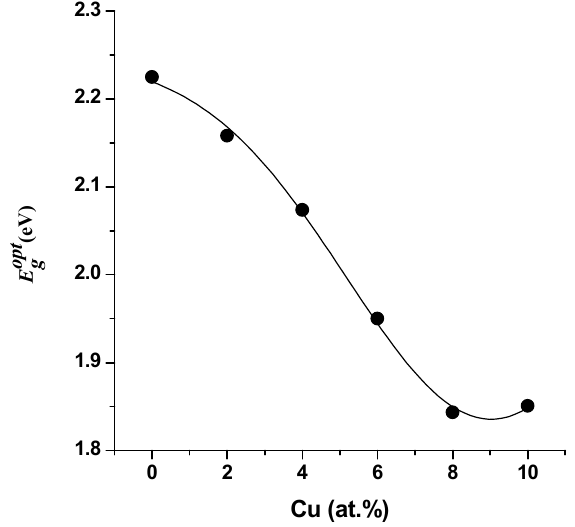
Cu (at.%) Figure 11. Energy gap as a function of the Cu concentration of the ZnTe:Cu films.